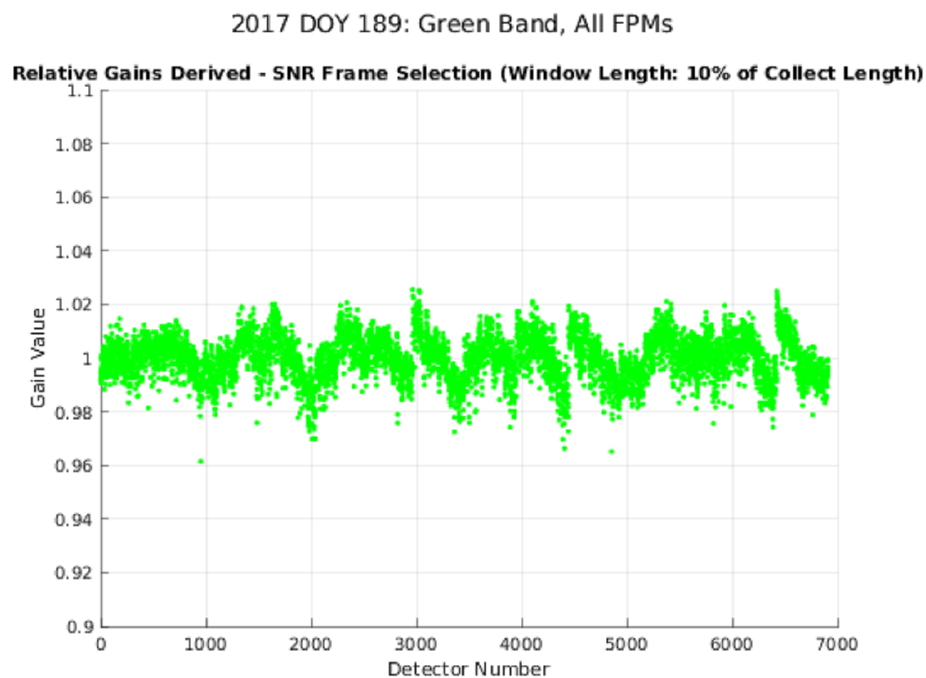
Figure 8. The values of relative detector gains tend to be on the range of 0.98–1.02, and the spatial shape of gains over each FPM tend to be random.